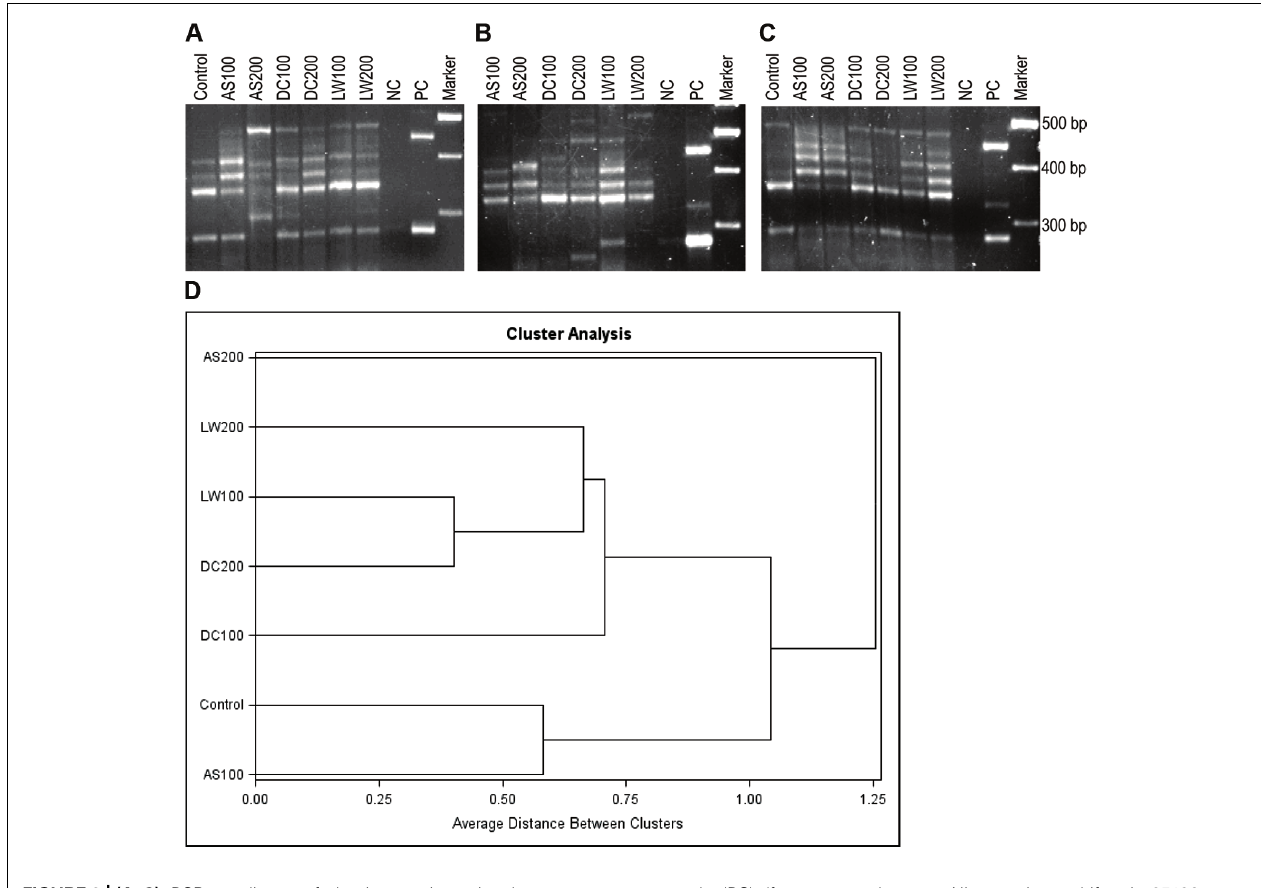
FIGURE 3 | (A – C) PCR amplicons of the intergenic region between amoC and amoA with amoC 305F- amoA 310R primer set from soil samples that received control, AS100, AS200, DC100, DC200, LW100, and LW200 treatments from three replicate field blocks (A – C) . Lanes NC, PC, and Marker correspond to negative control (NC), positive